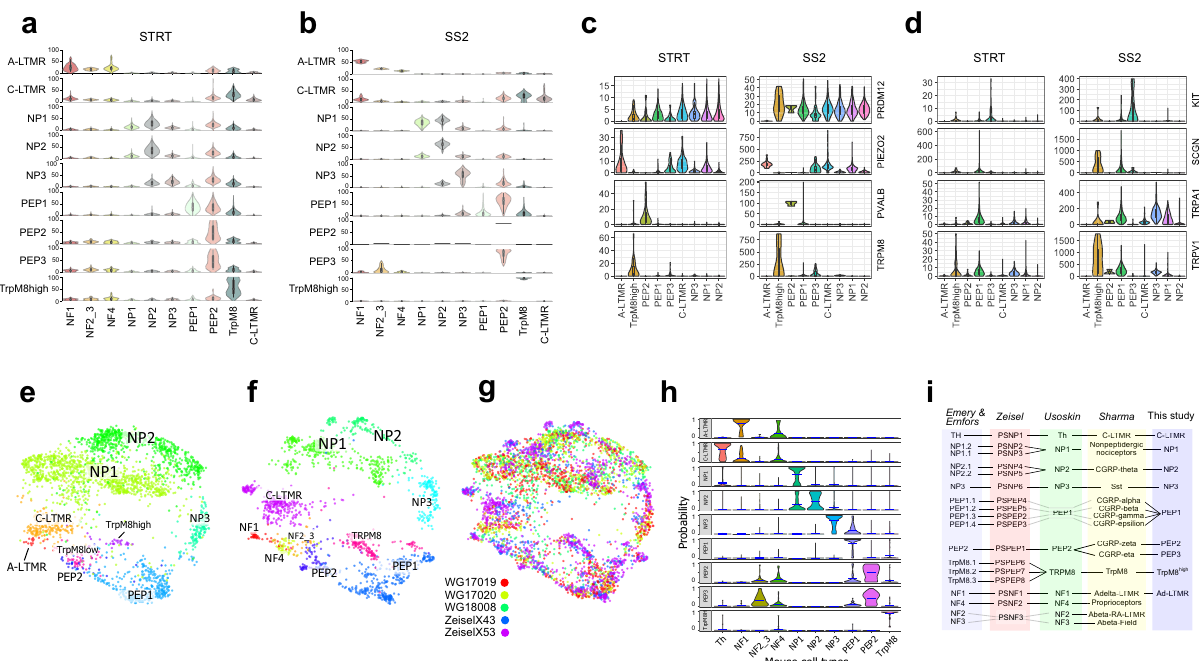
Fig. 3 Identi fi cation of primate correlates of mouse neuron types. a , b Violin plots showing prediction percent probability scores for each macaque cluster against established mouse DRG cell types trained with Usoskin nomenclature. a STRT-2i-seq ( n = 3), b Smart-seq2 ( n = 5). c Violin plots of markers expressed in macaque clusters. Y -axis, raw UMI counts for STRT-2i-seq (STRT) and counts for Smart-seq2 (SS2). d Violin plots showing genes differentially expressed between macaque PEP2 and PEP3 clusters. Boxplots in a – d de fi ne the median, interquartile range (IQR), and 1.5 × IQR (whiskers). e – g LargeViz plot showing cross-species clustering of macaque STRT-2i-seq and mouse Zeisel et al. datasets on a shared plot. e Macaque, f mouse, g merged plot (legend shows origin of samples, WG = macaque, Zeisel = mouse). h Probability plot of label propagation from mouse neuron types to macaque neuron types. Horizontal blue bars represent mean position for each distribution. i Synopsis of the corresponding DRG neuron types between mouse and macaque datasets and